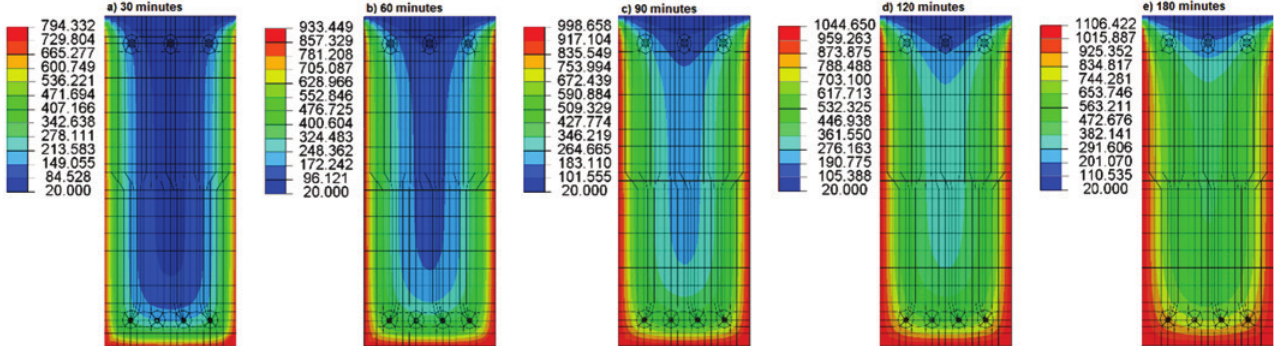
Figure 8 Isotherm B2-II for ratings of (a) 30, (b) 60, (c) 90, (d) 120, and (e) 180 minutes